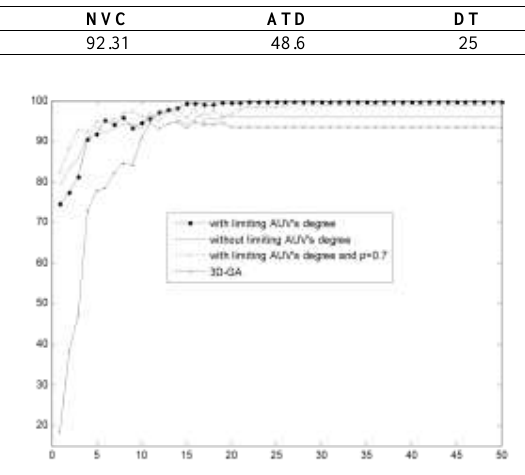
Figure 10. NVS vs. time step for scenarios 1-3and